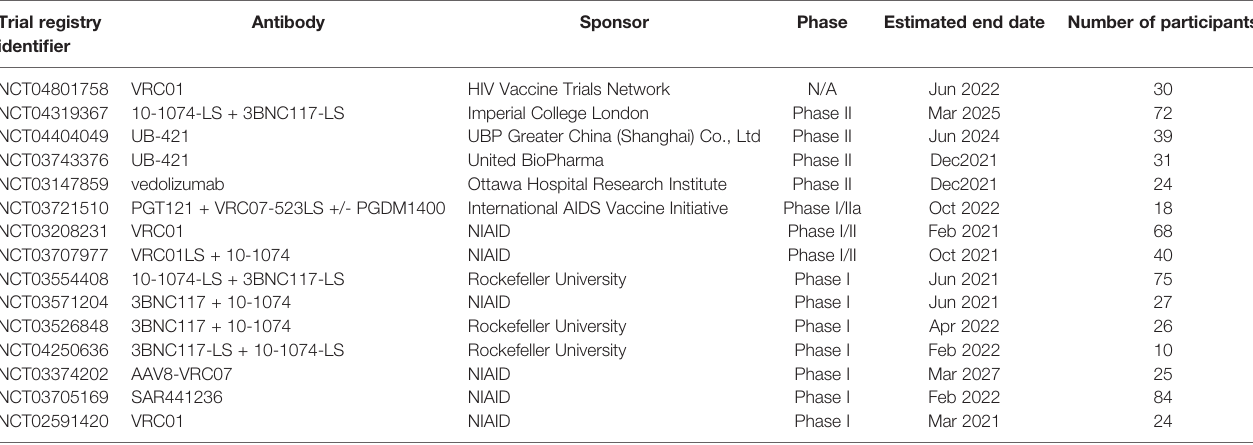
TABLE 2 | Ongoing clinical trials by using various anti-HIV-1 antibodies. Trial registry identi fi